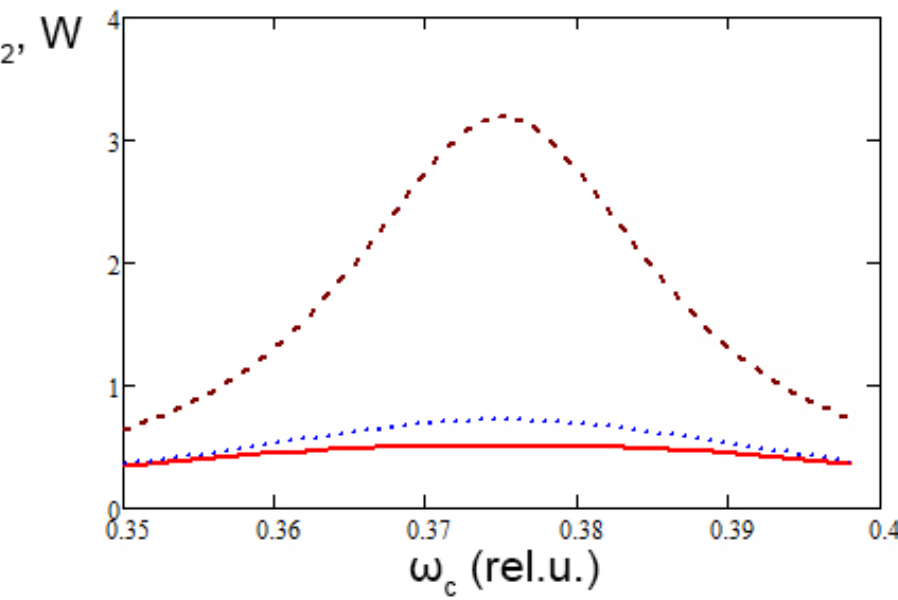
Figure 2. Long pulses τ > T 2 , moderate saturation s = 4 ( τ = 400, T 2 = 10 2 , Ω 0 = 0.02): solid line—Bloch equation solution, dotted line—generalized Karplus–Schwinger approach, dashed line—Lorentz profile neglecting saturation.